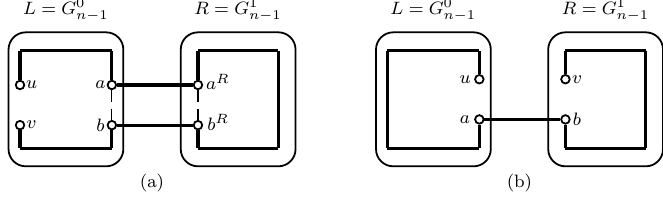
Figure 3. ( a ) Illustration of proof of Case 1.1; ( b ) Illustration of proof of Case 1.2.